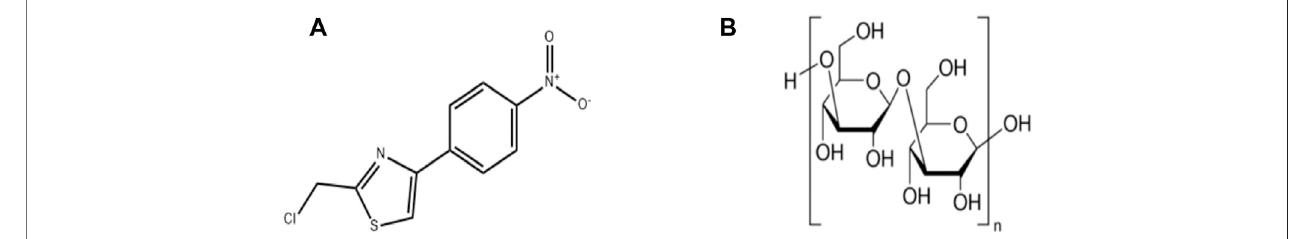
FIGURE 4 | Chemical structures of polysaccharides phytochemicals: (A) Astragalus polysaccharide (B)